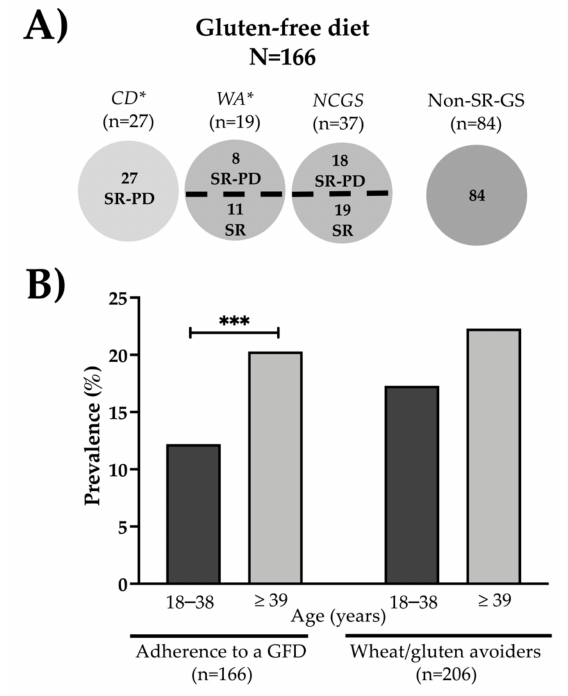
Figure 3. Prevalence of adherence to a GFD and wheat/gluten avoiders stratified by age. ( A ) Char- acteristics of individuals following a GFD. ( B ) GFD adherence and avoidance of wheat/gluten according to age. * One subject reported that a physician diagnosed her/him both CD and WA and was on a GFD. *** p < 0.001.